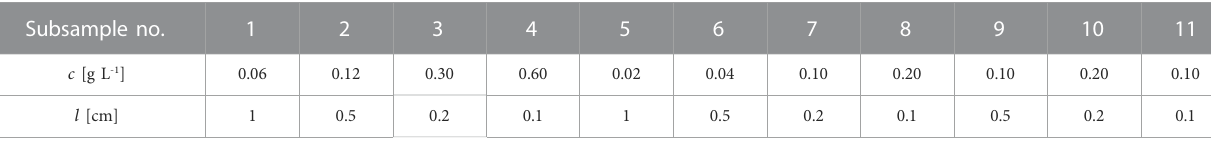
TABLE 1 The setups of concentration ( c ) and path length ( l ) for the potassium dichromate solutions. Subsample no.